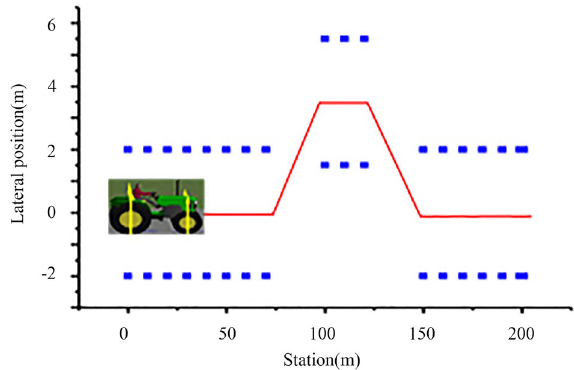
Figure 18. Moose test track.